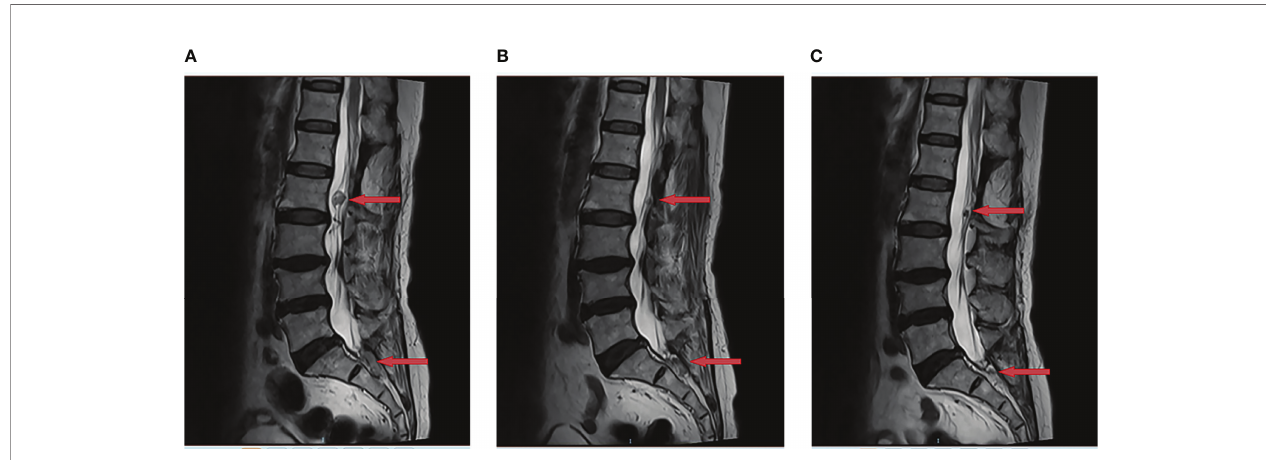
FIGURE 2 | Anlotinib resulted in tumor regression of multiple recurrent lumbar and sacral cord hemangioblastoma. This is a sagittal magnetic resonance imaging (MRI) view of lumbar and sacral spine; (A) The two lesions at L2 and S1-S2 were observed to have increased in size (red arrow) in June 2021; (B) The MRI demonstrated tumor regression (red arrow) following one month of anlotinib in July 2021; (C) The MRI showed further regression in the enhancing tumor (red arrow) following three months of anlotinib in Sep